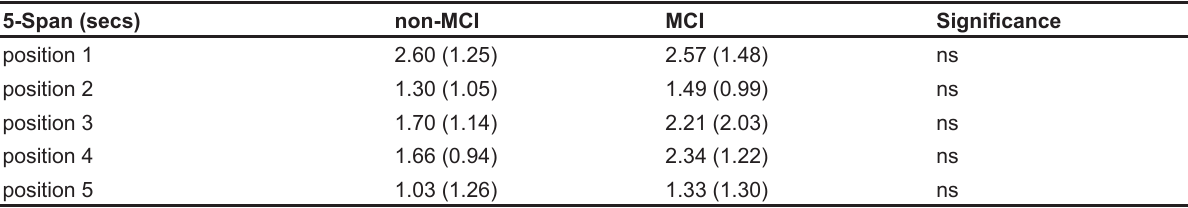
Table 4. Symbolic working memory—latency for serial order recall ( continued ) 5-Span